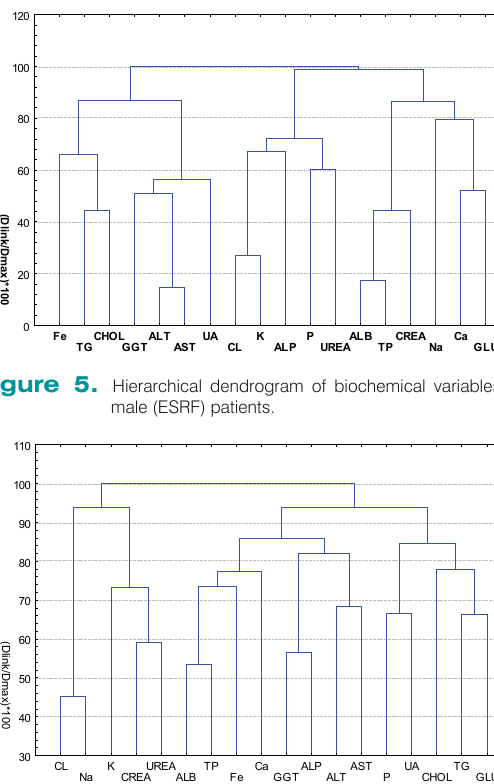
Figure 6. Hierarchical dendrogram of biochemical variables for female